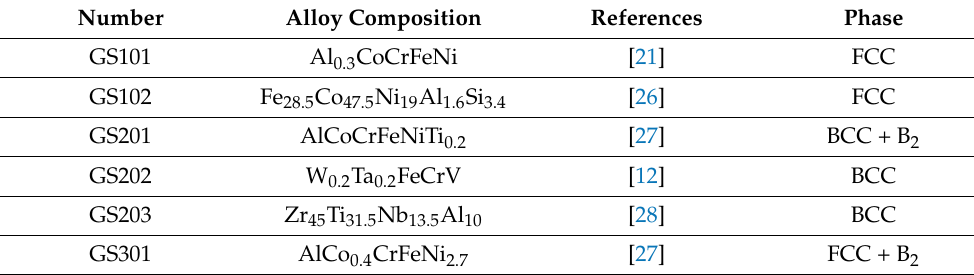
Table 1. Sorting and numbering of our research group’s HEAs. Number Alloy